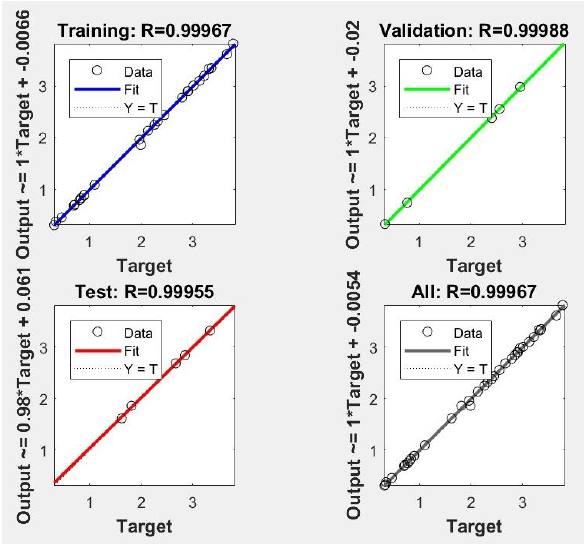
Figure 5. The results of neural network training.